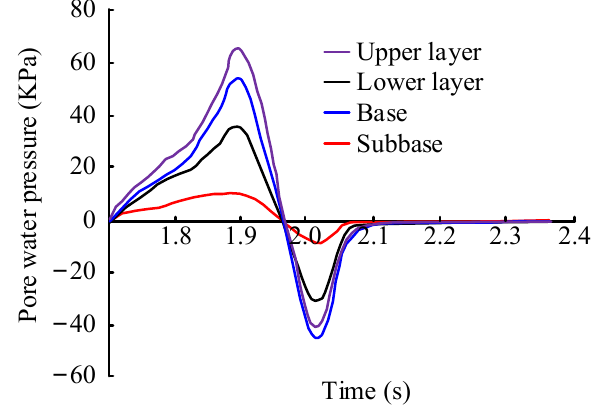
Figure 9. Pore water pressure after pervious concrete.